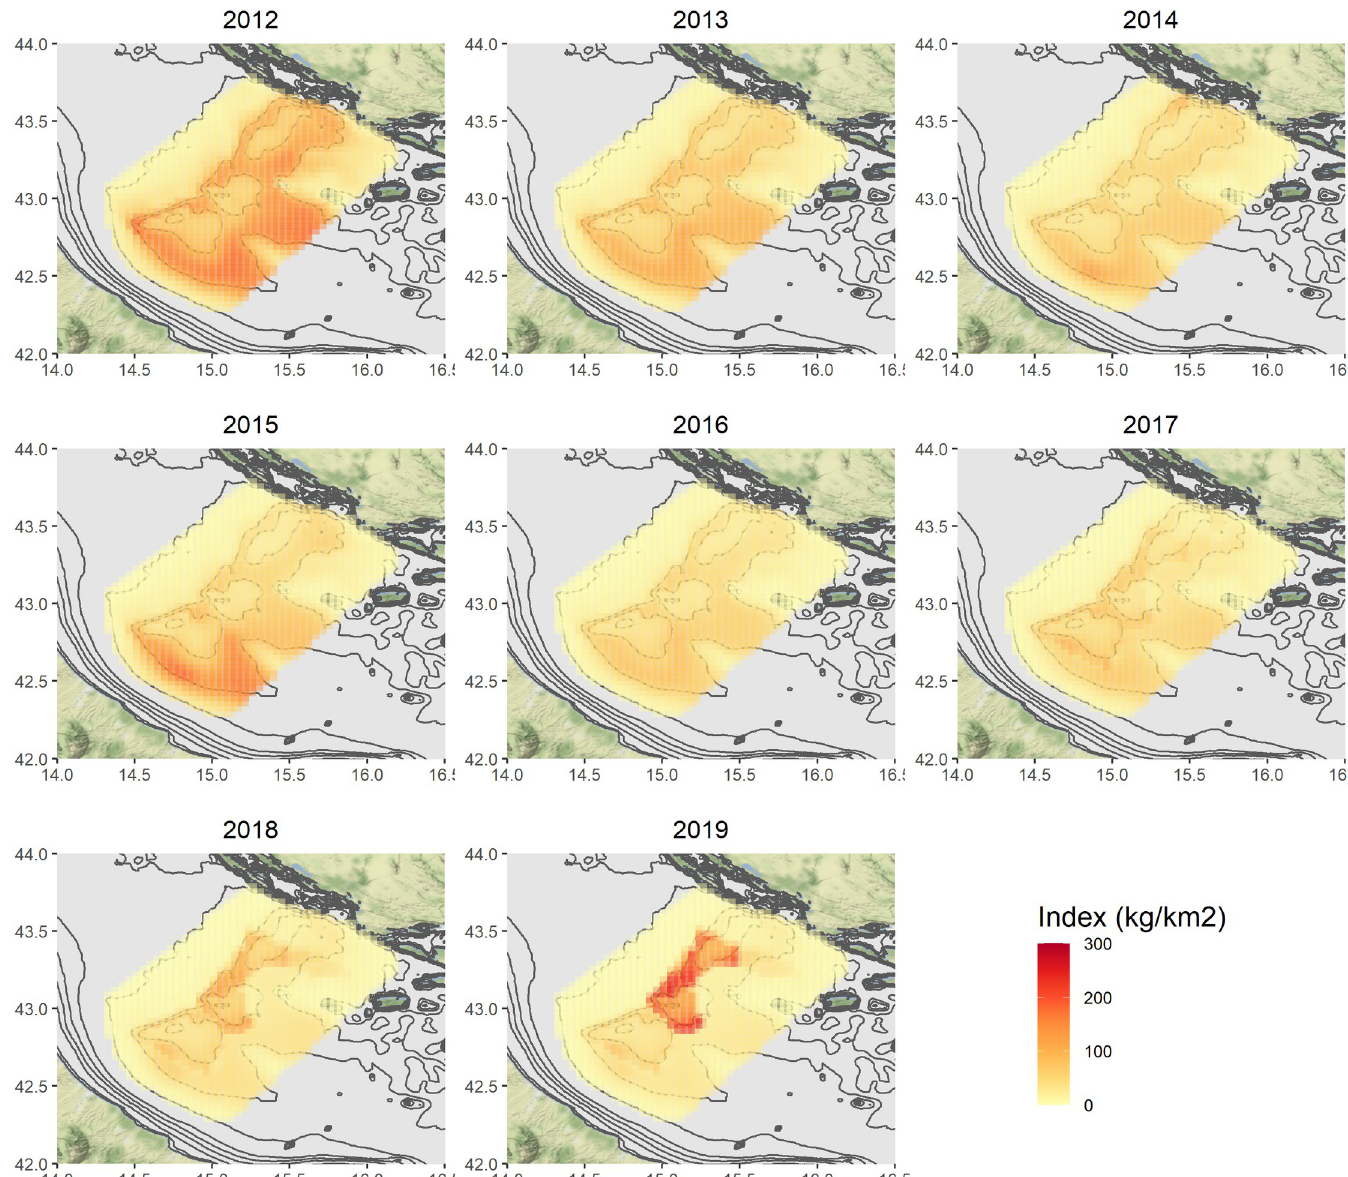
Fig 4. Predicted spatial distributions of Nephrops biomass index (kg/km 2 ) for the spring time series. Maps were made using the ggmap package [108] for R. Bathymetry layer source: [75]. Map tiles by Stamen Design, under CC BY Data by OpenStreetMap, under ODbL. from 24.6 kg/km 2 to 71.3 ( ± 19) kg/km 2 (Fig 8, panels a); in the autumn survey time series an important difference was found in 2015 with an increment of about 33% from 24.9 kg/km 2 to 37.33 ( ± 9.1) kg/km 2 (Fig 8, panels b). Apart from these two exceptions, the mean predicted values for the biomass index were always within the interquartile range (i.e. middle 50% of the observed data) (Fig 8, panels a and b). For the density models, the highest discrepancy in the spring survey time series was as well detected in 2012, with a huge increment from about 2704 N/km 2 to 5723.27 ( ± 1910.1) N/km 2 (Fig 8, panel c). Differently from the biomass models, for density indices in the autumn survey time series the maximum differences of about 50% were